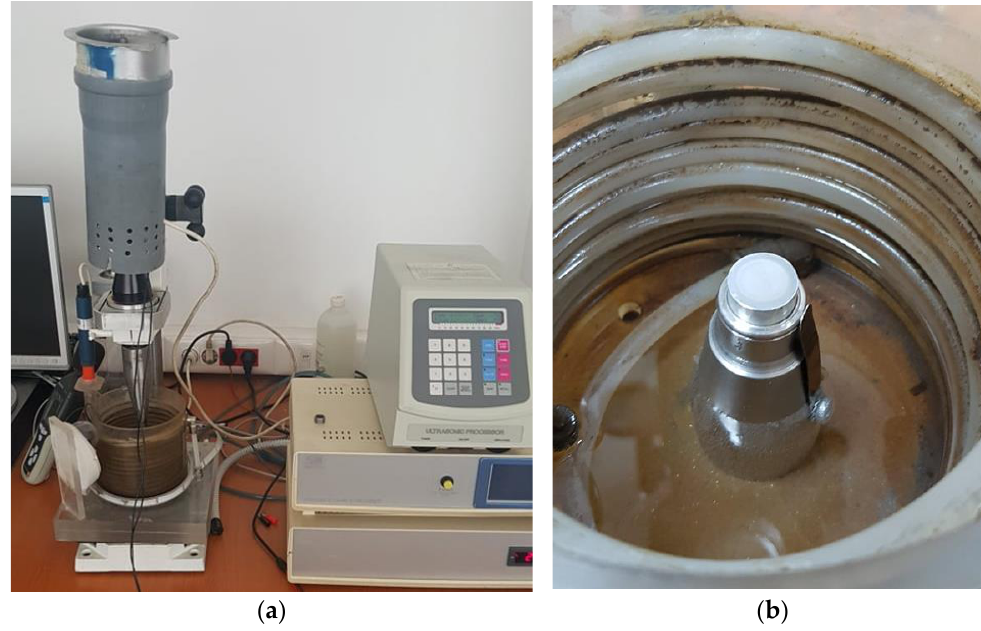
Figure 6. Experimental stand: ( a ) overview; ( b ) detail of the sample-fixing system. The functional parameters of the device were: